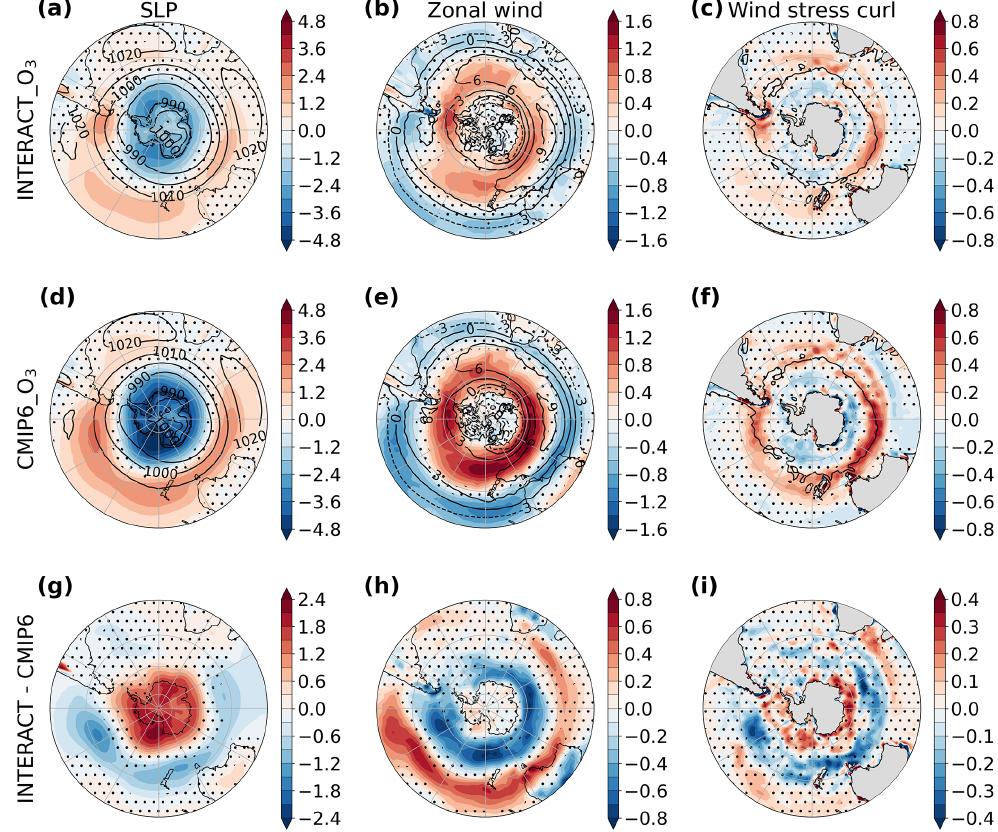
Figure 14. Changes in annual mean sea level pressure ( a , d ; hPa), surface zonal wind ( b , e ; ms − 1 ), and wind stress curl ( c , f ; 10 − 7 Nm − 3 ) due to ozone recovery and GHGs combined, in INTERACT_O 3 (a–c) and CMIP6_O 3 (d–f) , and the difference between the INTERACT_O 3 and the CMIP6_O 3 changes (g–i) . The stippling in (a) – (f) masks regions where the changes are not significant at the 95% confidence interval based on a two-tailed t test, and the stippling in (g) – (i) masks regions where the difference is lower than 2 σ inferred from the spread of the individual ensemble members. The contour in (c) and (f) marks the location of zero-wind-stress curl, while contours in (a) , (b) , (d) , and (e) show the current-day (2011–2030) climatologies in the respective